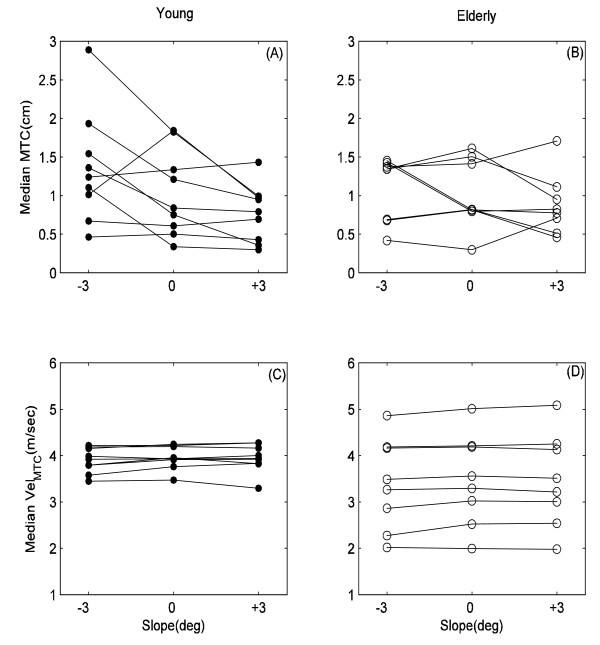
Median values of MTC and VelMTC at slopes. Median values of MTC and VelMTC of individual participants during walking at -3°>, 0° and +3° slopes.